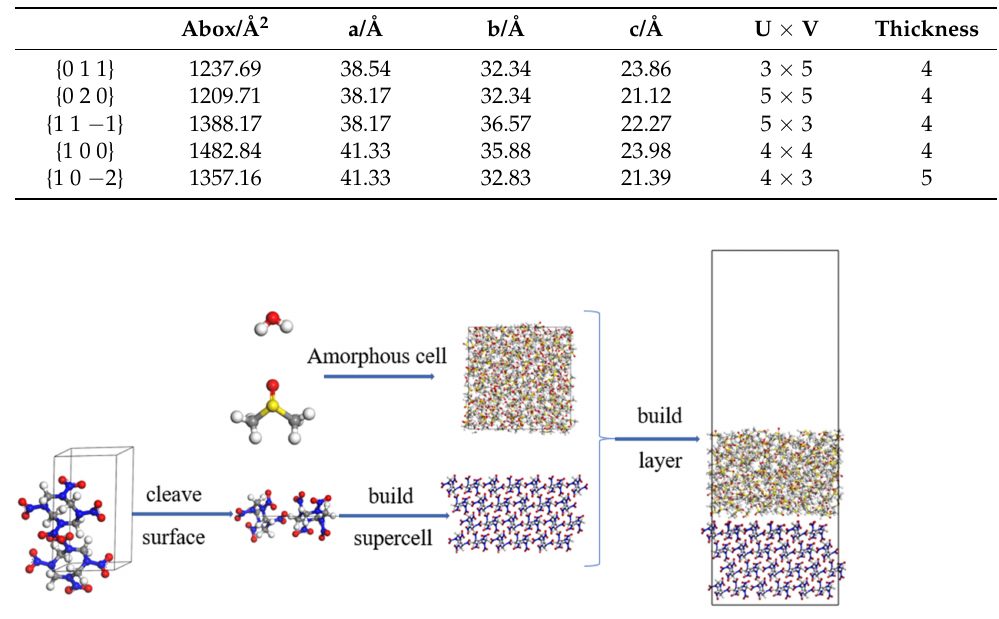
Table 1. Extending the size of β -HMX supercells.